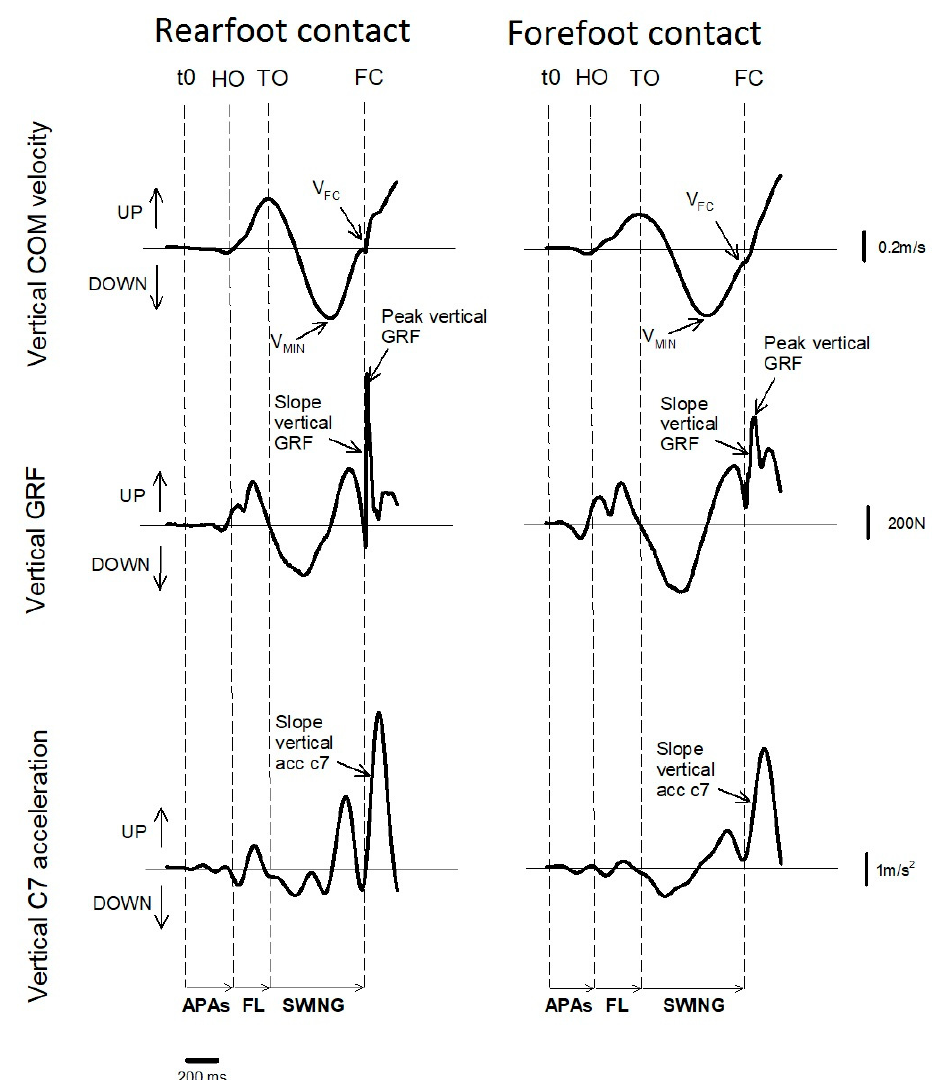
Figure 3. Typical biomechanical traces and representation of the main experimental variables (vertical direction). Traces are from one representative subject initiating gait in the ( left ) rearfoot strike condition and the ( right ) forefoot strike condition. COM, GRF, acc: centre of mass, ground reaction forces, and acceleration, respectively; V MIN , V FC : peak of negative vertical COM velocity and COM velocity at foot contact (FC). Vertical dashed lines: t 0 onset variation of biomechanical traces; HO: swing heel-off; TO: swing toe-off; FC: swing foot contact. Horizontal arrows. APAs: anticipatory postural adjustments; FL: swing foot lift; SWING: swing phase of gait initiation.